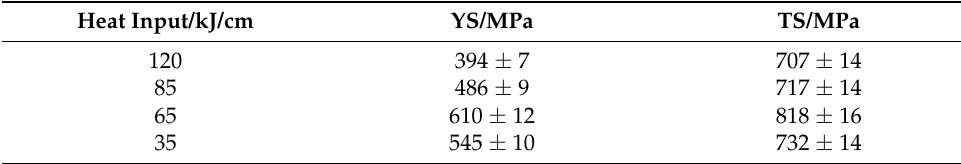
Table 1. Tensile mechanical properties.